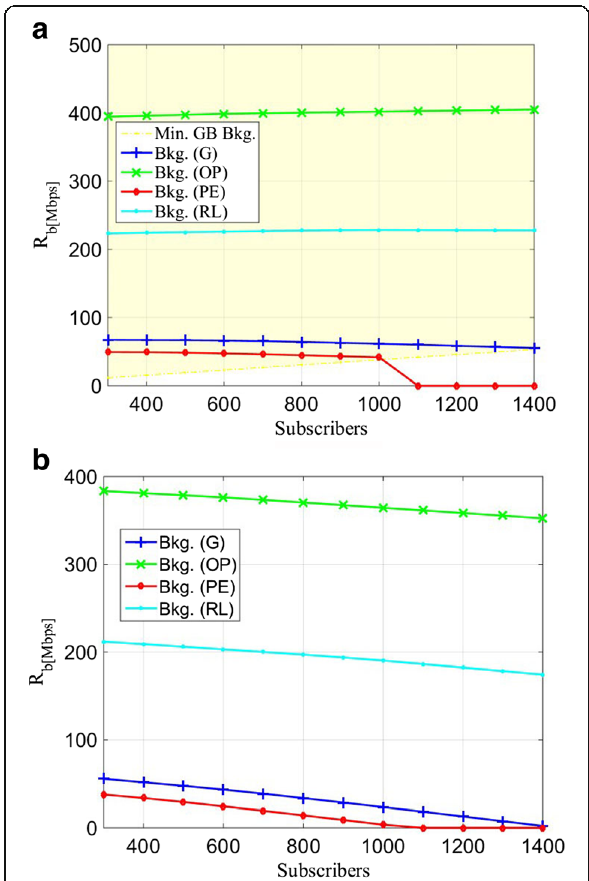
Fig. 12 The data rate allocated to the background class. a VNO